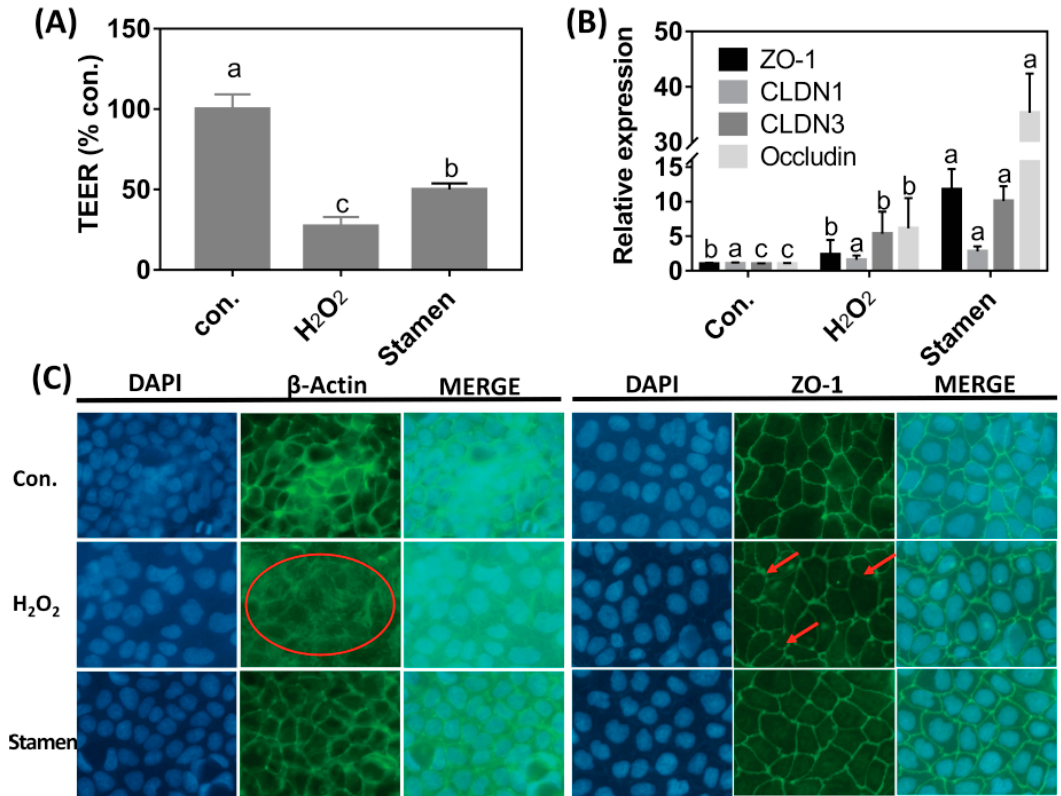
Figure 5. Effect of total phenolic extract (TPE) from the stamen on the transepithelial electrical resistant (TEER) value ( A ), tight junction protein expression ( B ), and β -actin and ZO-1 staining ( C ) of Caco-2 cells. Cells were treated with 2.0 mM H 2 O 2 1 h, and then treated with 1 μ g/mL TPE from stamen for 4 h. H 2 O 2 treatment: cells were treated with 2.0 mM H 2 O 2 for 1 h firstly, then treated with a regular medium for 4 h. The con. means negtive control (no H 2 O 2 or TPE treatment). The magnification in Figure ( C ) is 40×. Red ellipse and red arrow were used to line out the changes of structure of β -actin and ZO-1, respectively. Data are expressed as mean ± SD. Different lower case letters indicate the significant difference at p < 0.05 for each index.